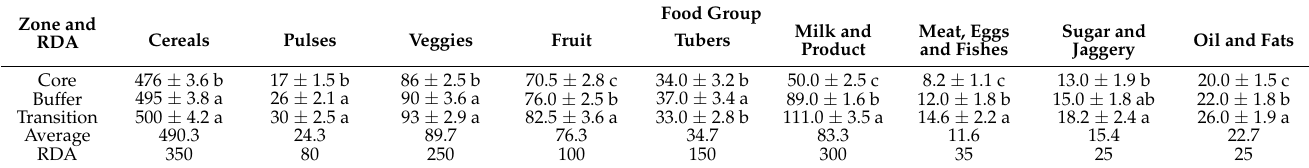
Table 3. Per capita food groups intake (consumption- g/day) pattern of Indigenous communities in AABR, Central India. Zone and RDA